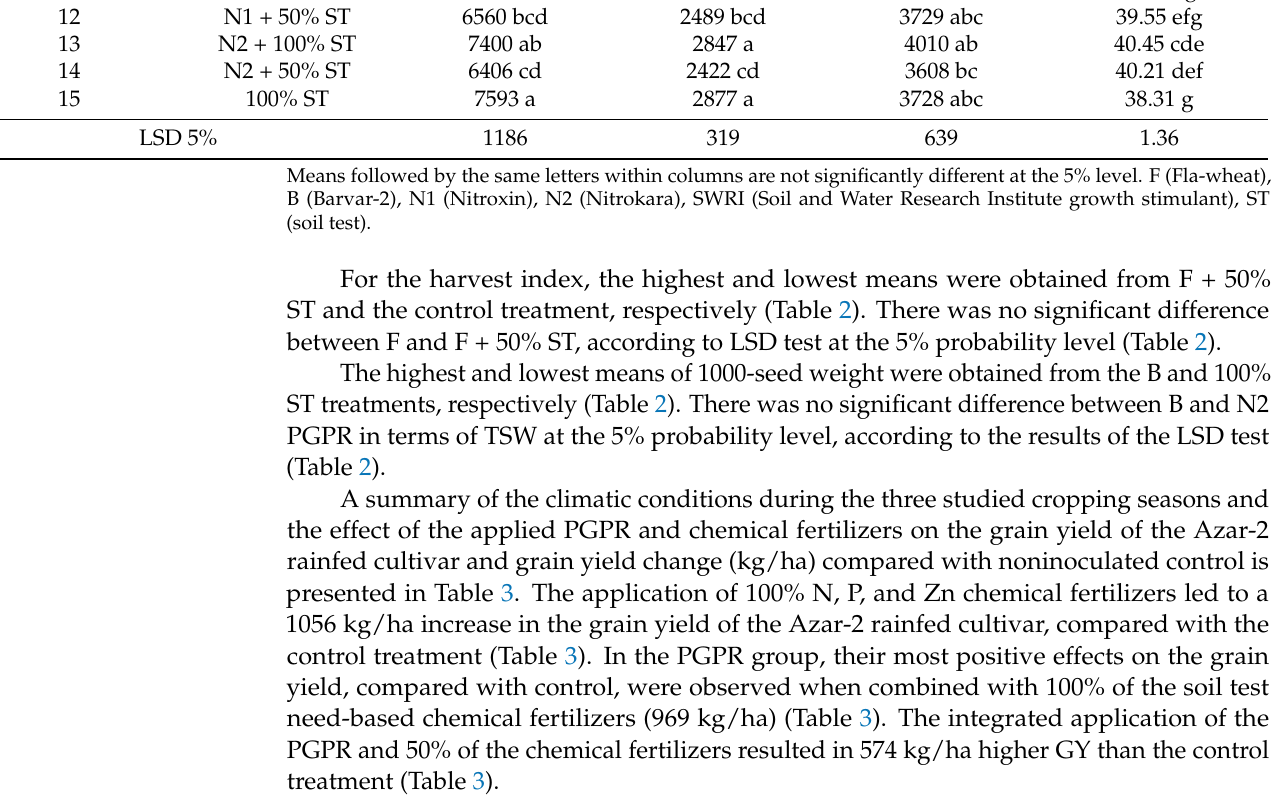
Table 3. Summary of climatic factors and changes in the grain yield of the Azar-2 rainfed wheat cultivar during three cropping seasons (2016–2017, 2017–2018, and 2018–2019) and under the effects of the PGPR and chemical